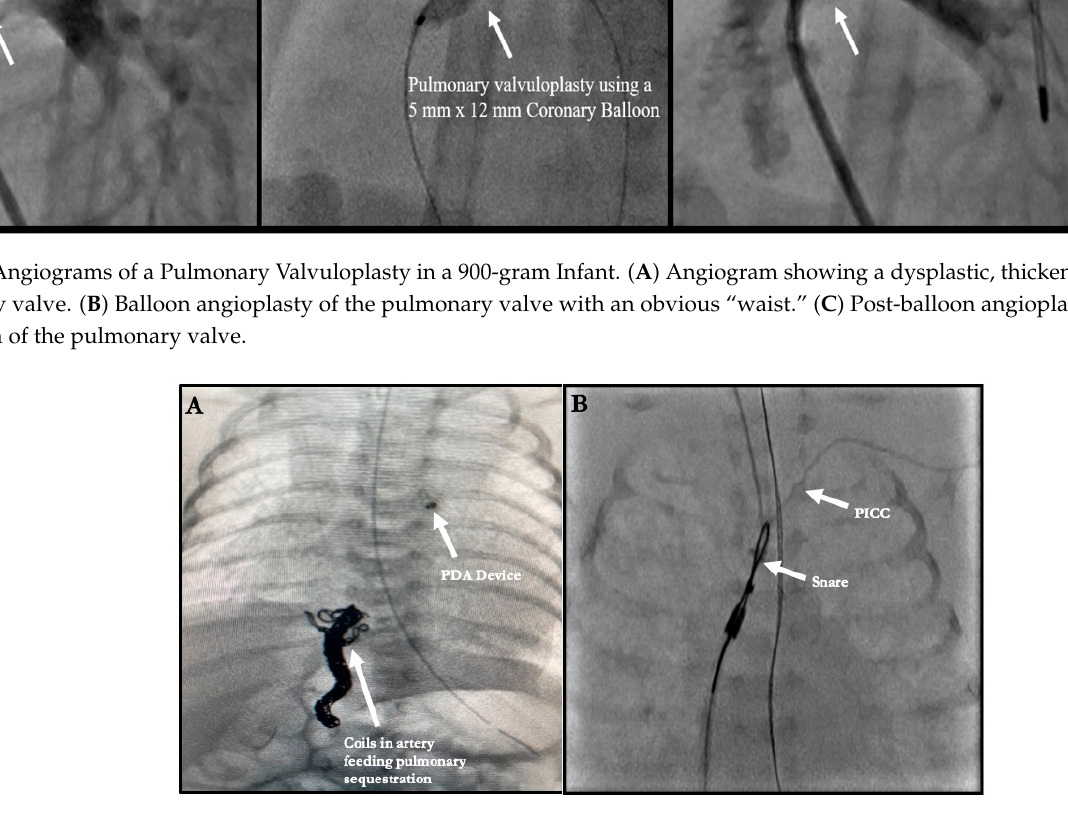
Figure 2. ( A ) Patient in whom the afferent artery to the sequestrated right lower lobe was coil em- bolized through the PDA with eventual device closure of the PDA. ( B ) Foreign Body Retrieval. Re- trieval of a retained peripherally inserted central catheter